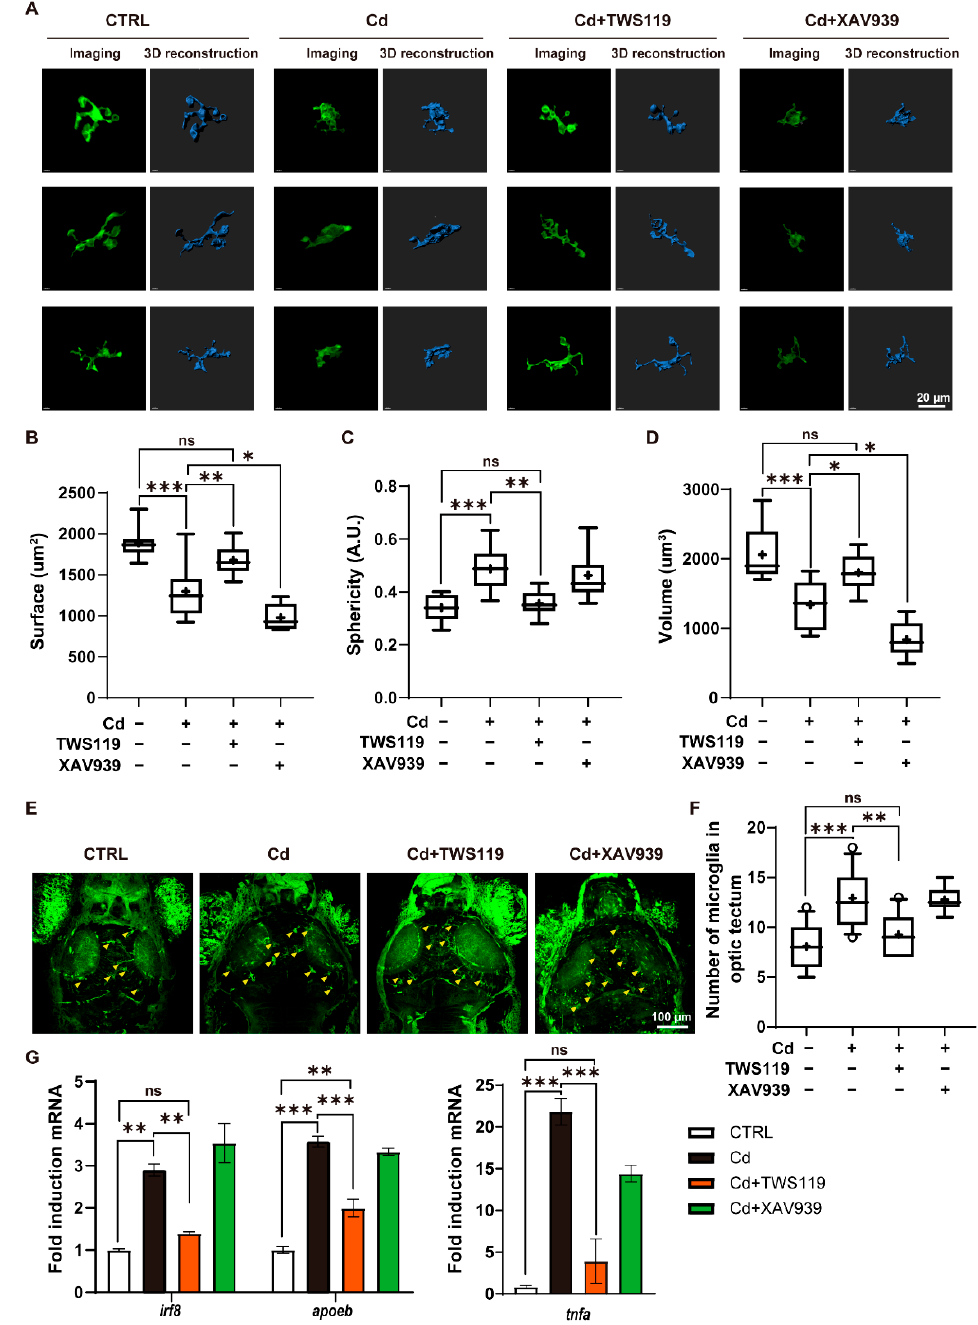
Figure 6. Role of zebrafish Wnt signaling pathway in Cd 2+ -induced microgliosis and neuroinflammation. ( A – D ) Morphological alterations of microglia in 6 dpf Tg(ApoE-EGFP) zebrafish larvae, and quantification of morphological parameters. ( E , F ) In vivo neuroimaging and microglia counting in the optic tectum region of 6 dpf zebrafish larvae. ( G ) Expression patterns of genes closely related with microgliosis and neuroinflammatory response. The numerical values are presented as either mean ± SEM in histograms, or median and mean, while whiskers show 90% confidence levels in boxplots. The results of either nonparametric test or ANOVA followed by multiple comparison test are listed in Table S2. “*” indicates significant differences (* p < 0.05, ** p < 0.01, *** p < 0.001).